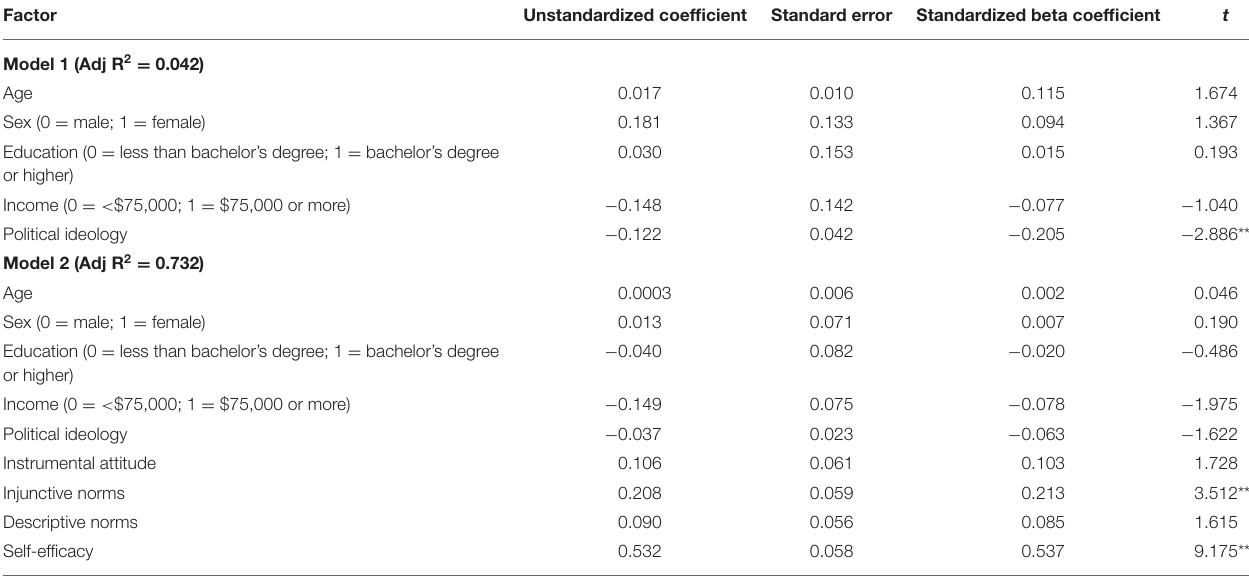
TABLE 2 | Results from multiple regression analysis testing factors associated with intention to stay home.